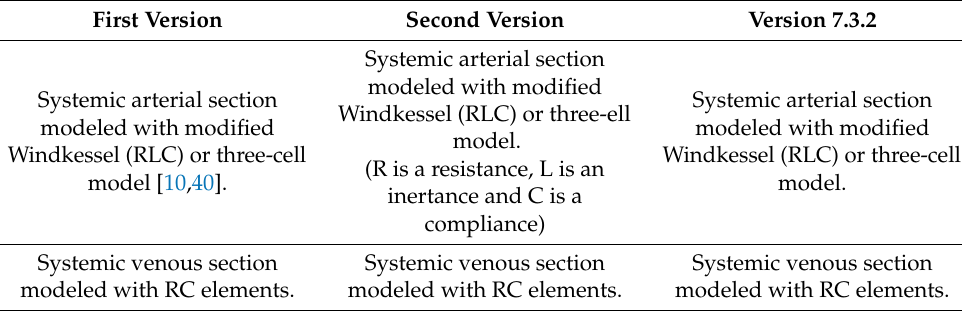
Table 2. Evolution over time of numerical models of the systemic